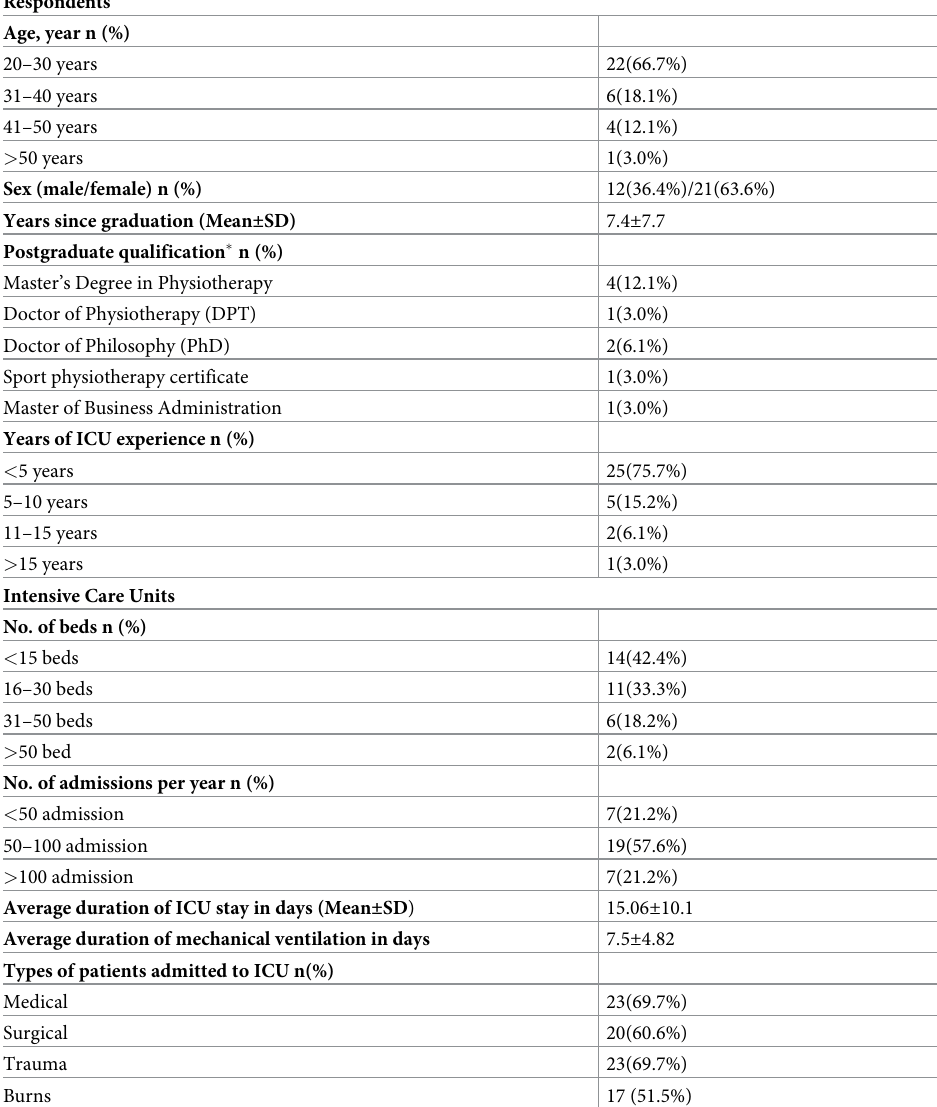
Table 1. Characteristics and descriptive data of respondents and intensive care